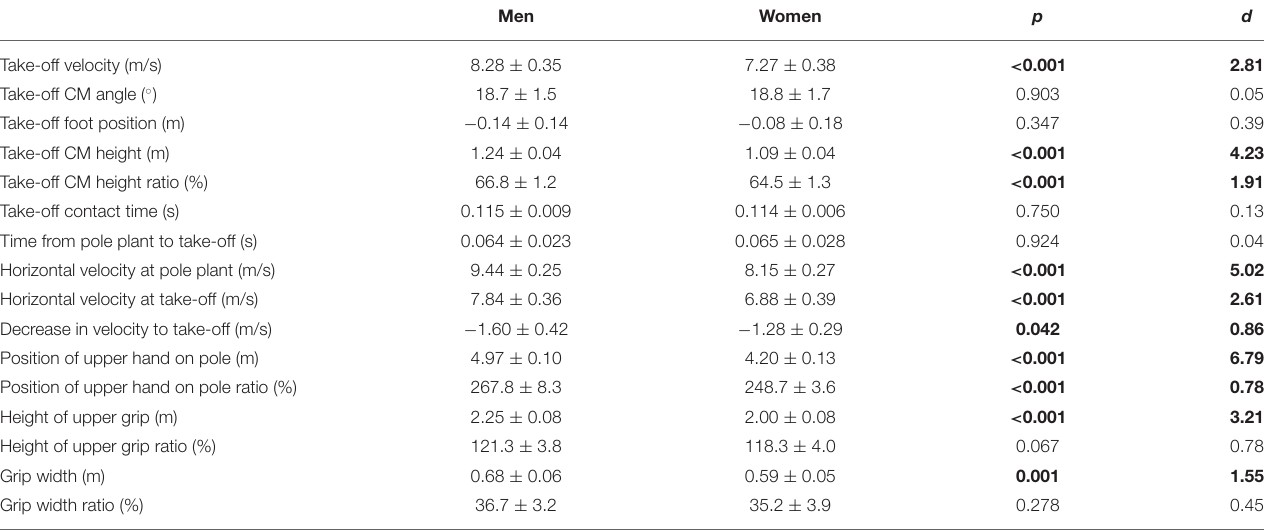
TABLE 3 | Mean SD values for take-off spatiotemporal ±